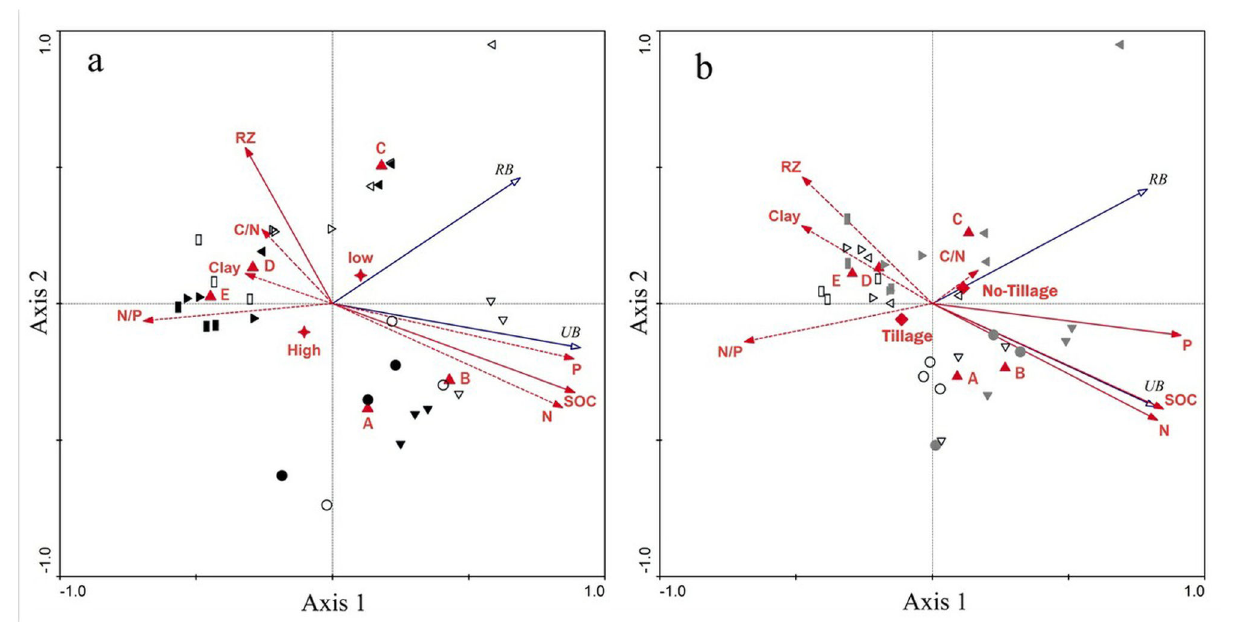
Figure 3. Redundancy analysis of soil productivity data in (a) different erosion intensities with no-tillage operation and (b) same erosion intensity but different farming method systems. Significant soil variables and supplementary parameters are indicated by solid lines with filled arrows and dotted lines with filled arrows, respectively. Soil productivity variables are indicated by solid lines with unfilled arrows. Samples from subplots A, B, C, D, and E are represented by circle, inverted triangle, left triangle, right triangle, and box, respectively. Black-filled symbols in Figure 3a refer to the samples from high rainfall intensity treatment, and unfilled symbols refer to the samples from low rainfall intensity treatment. Gray-filled symbols in Figure 3b refer to the samples from no-tillage treatment, and unfilled symbols refer to the samples from tillage treatment. doi: